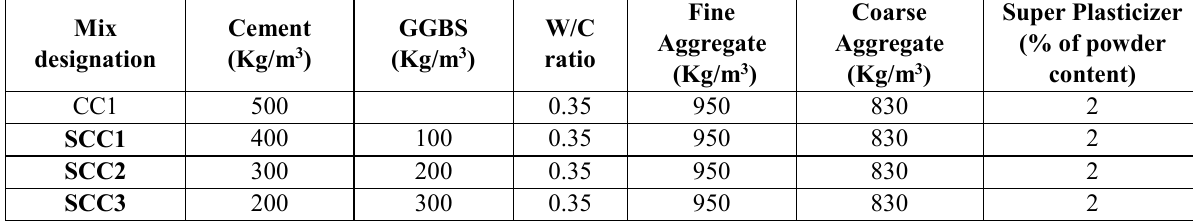
Quantities of Constituent materials for SCC